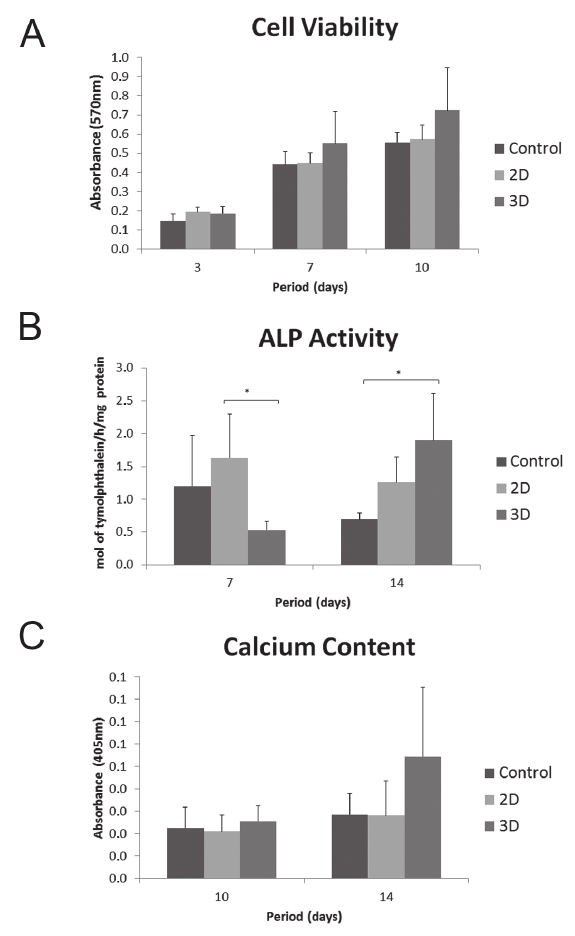
Figure 2- A - Cell viability analysis (MTT assay) at 3,